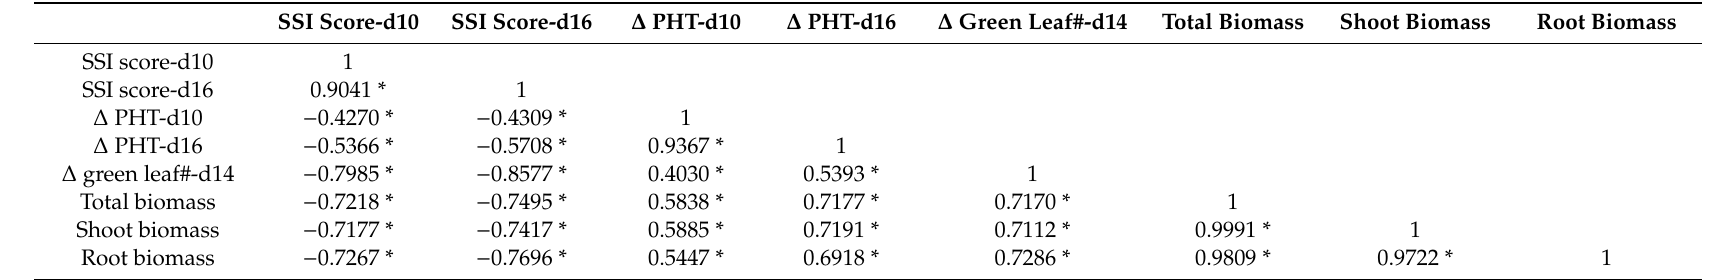
Table 2. Correlation coe ffi cients among seedling salt tolerance traits determined under hydroponic conditions (N =